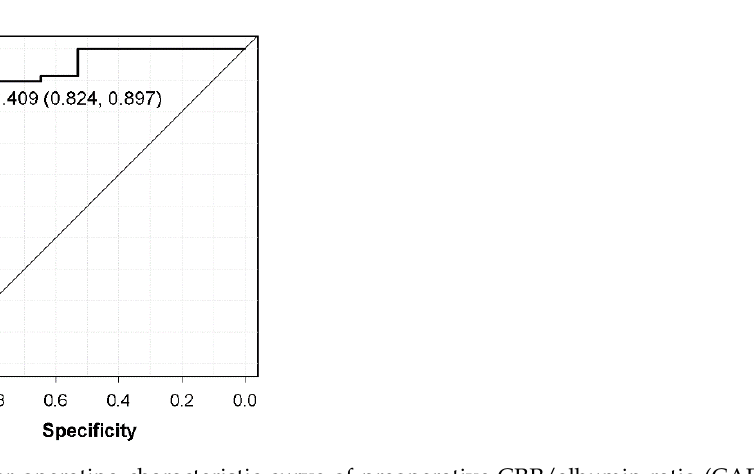
Figure 2. Receiver operating characteristic curve of preoperative CRP/albumin ratio (CAR) for 6–month mortality after palliative surgery and determination of the CAR cut–off value.